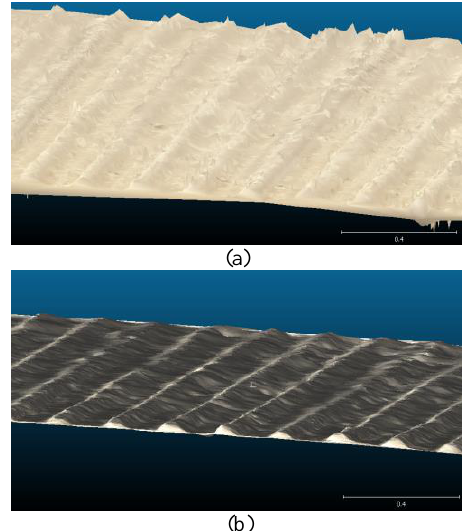
Figure 6: Smoothed and exaggerated point cloud